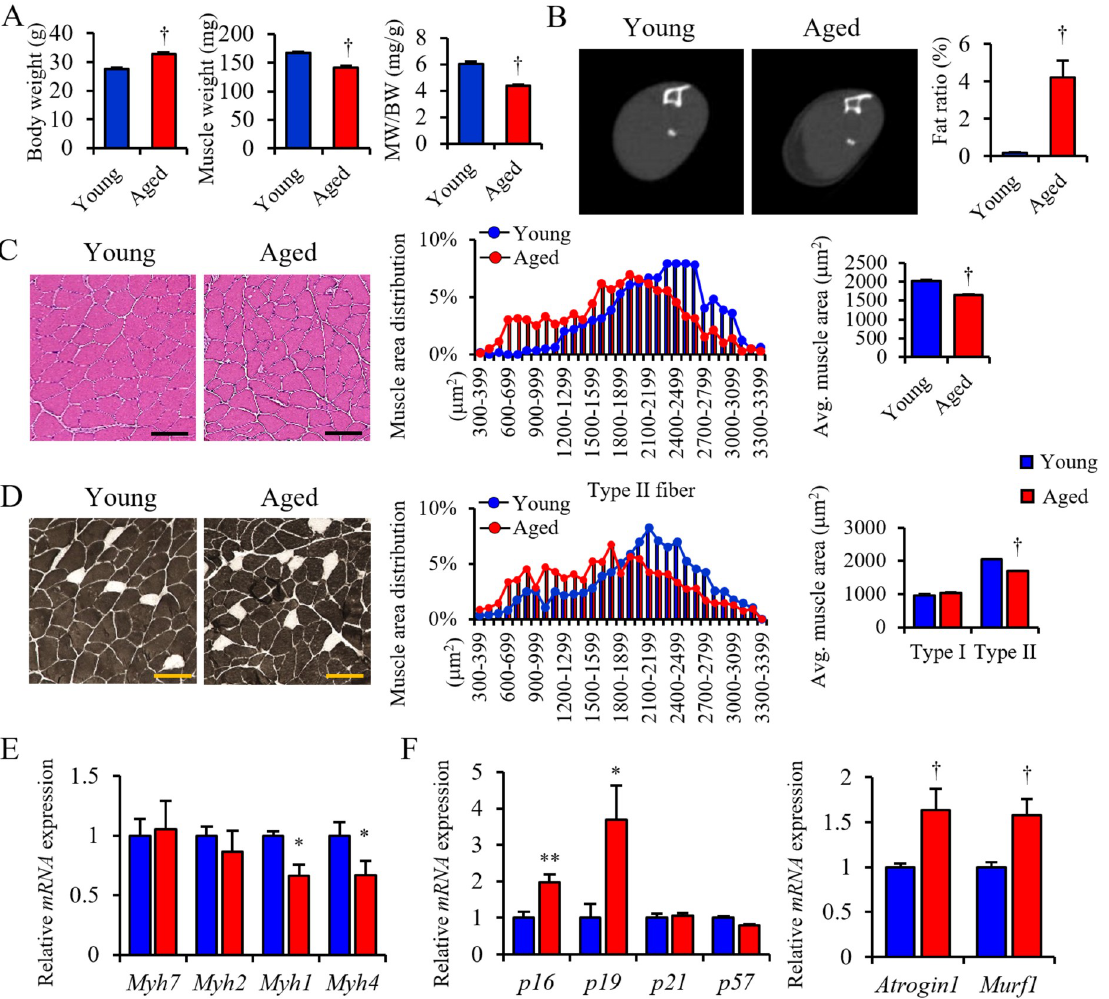
Fig 1. PMAT deposition is positively correlated with sarcopenia. (A) Body weight (BW), muscle weight (MW) and MW/BW ratio in young and aged mice. (B) Representative CT images (left panels) and the fat ratio based on CT analysis (right panel) in lower limbs of young and aged mice. (C) Representative HE staining (left panels), quantified distribution (middle panel) and average muscle fiber cross-sectional area (CSA) (right panel) in lower limbs of young and aged mice. (D) Representative ATPase staining (left panels), distribution CSA of type II muscle fibers (middle panel) and average CSA of type I (white cells in left panel) and type II (black cells in left panel) muscle fibers in lower limbs in young and aged mice (right panel) (n = 50–100, type I; n = 1200–1500, type II). (E, F) Relative levels of transcripts marking skeletal muscle myosin subtypes ( Myh7 , Myh2 , Myh1 and Myh4 ) (E), cellular senescence ( p16 , p19 , p21 and p57 ), and protein degradation ( Atrogin1 and Murf1 ) (F) in gastrocnemius of young and aged mice. Transcript levels were normalized to 18s mRNA; values in young mice were set to 1. Young mice were 3-6-months-old and aged mice were 18-22-months-old. (Scale bar: 100 μ m in c, d). (n = 6–8 per group in a, e, f). All data are presented as means ± S.E. Statistical significance was determined by Student’s t-test. � , p < 0.05; �� , p < 0.01; †, p <